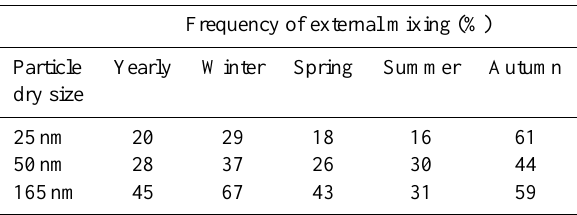
Table 4. Degree of external mixture, split by season. Yearly average values include the complete measurement years